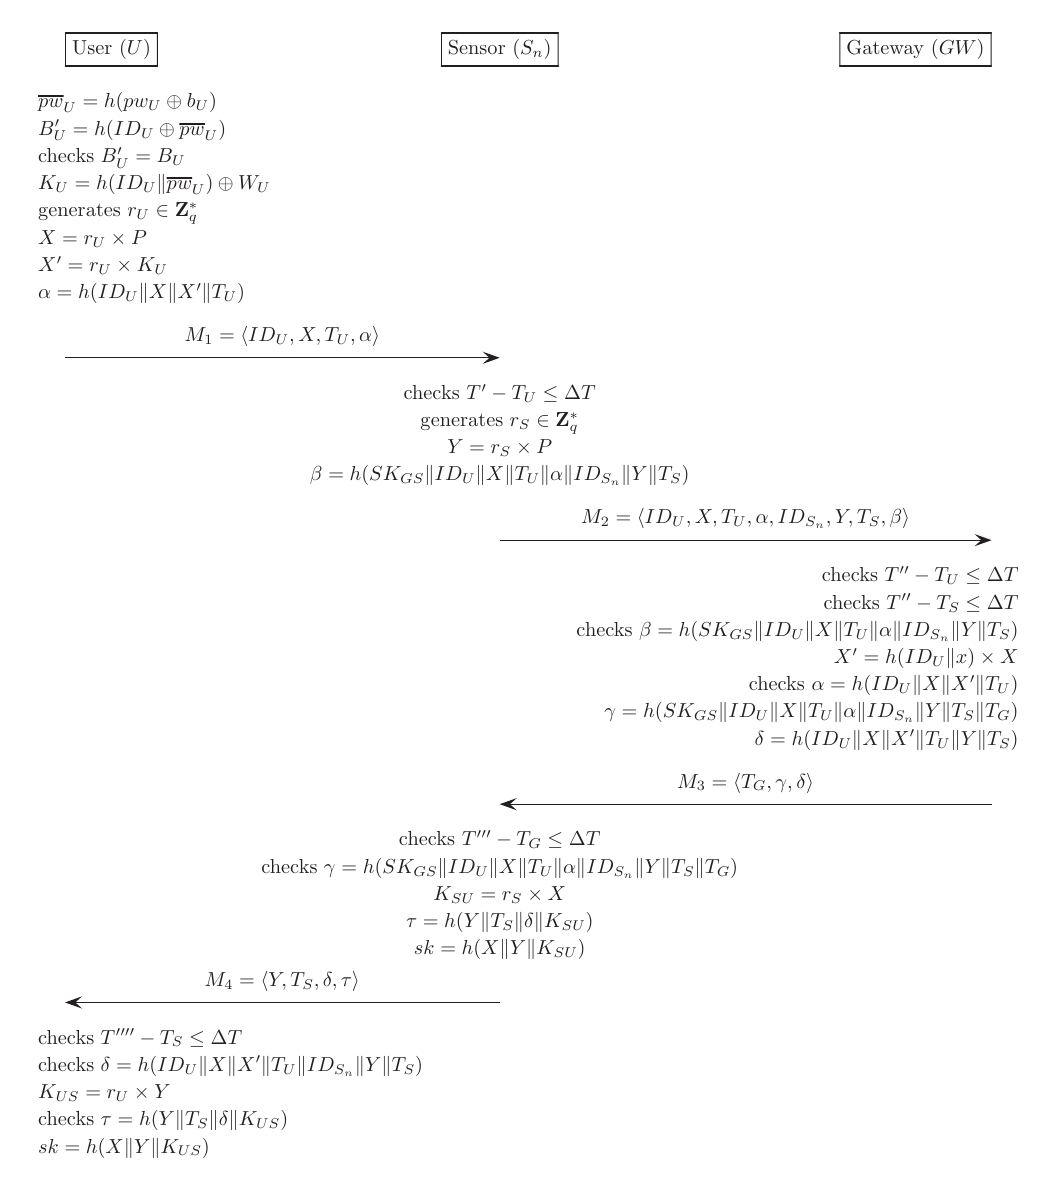
Figure 2. The login and authentication phases of Shi et al .’s